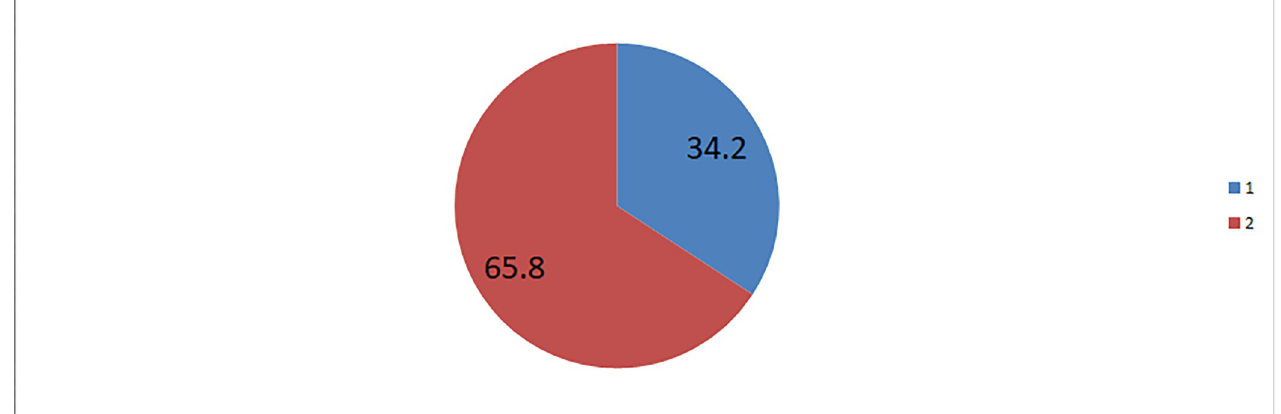
Fig 3. Perception of risk regarding the use of COVID-19 vaccine among pregnant women in Motta town and Hulet Eji Enese district, northwest Ethiopia, 2021. 1 = perception of not risk for pregnancy, 2 = perception of risk for pregnancy.